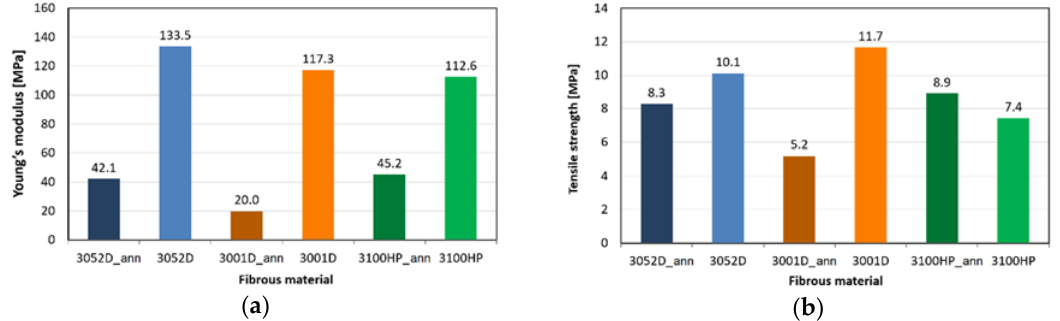
Figure 6. Young’s modulus ( a ) and tensile strength ( b ) of annealed (ann) and non ‐ annealed PLA mats.